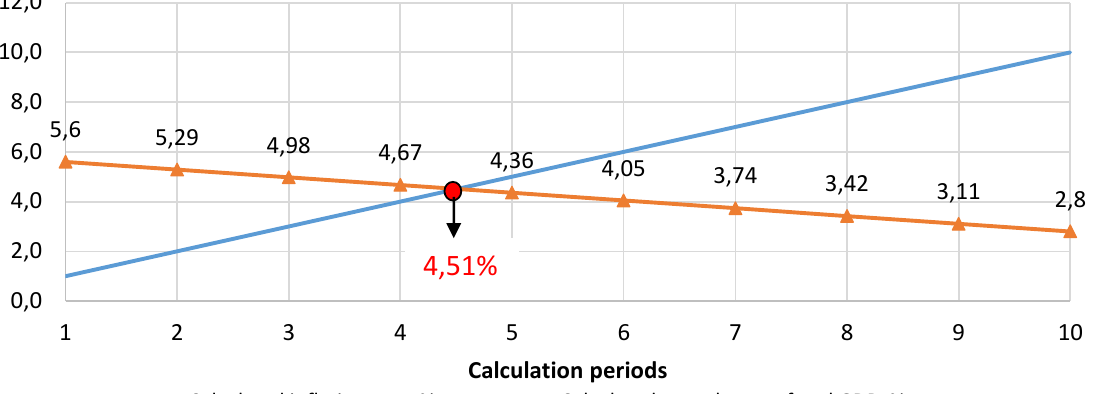
Figure 2. The empirical dependence of the real GDP growth rate on the inflation rate in Ukraine according to the regression equation